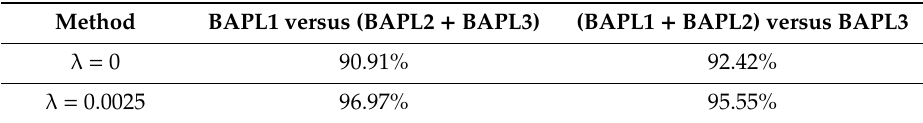
Table 7. Comparison of two-class classification